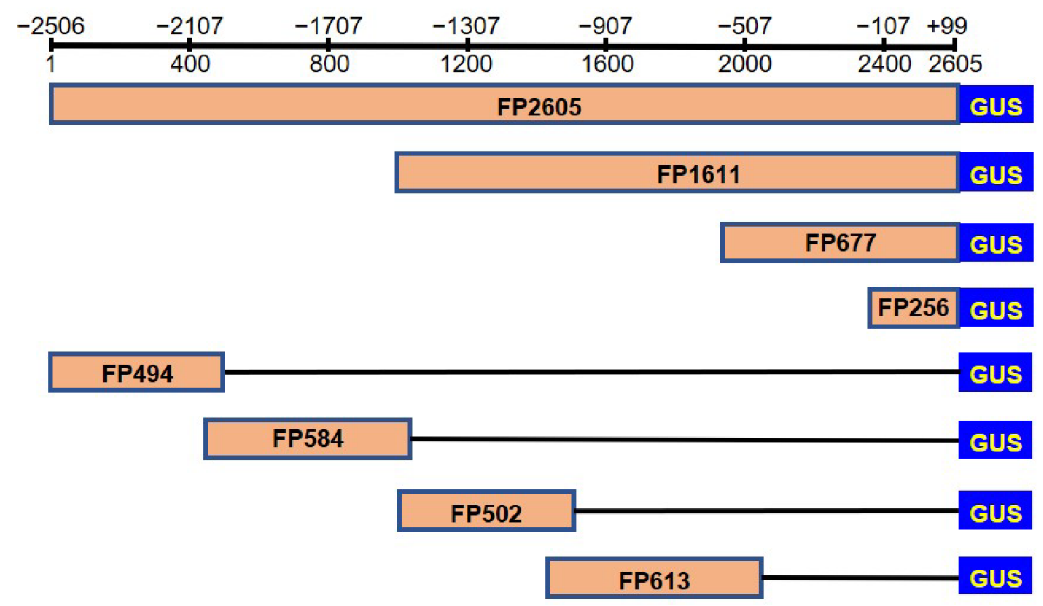
Figure 3. Construction of expression vectors. The sequences of FP2605 ( −2 506~+99 bp), FP1611